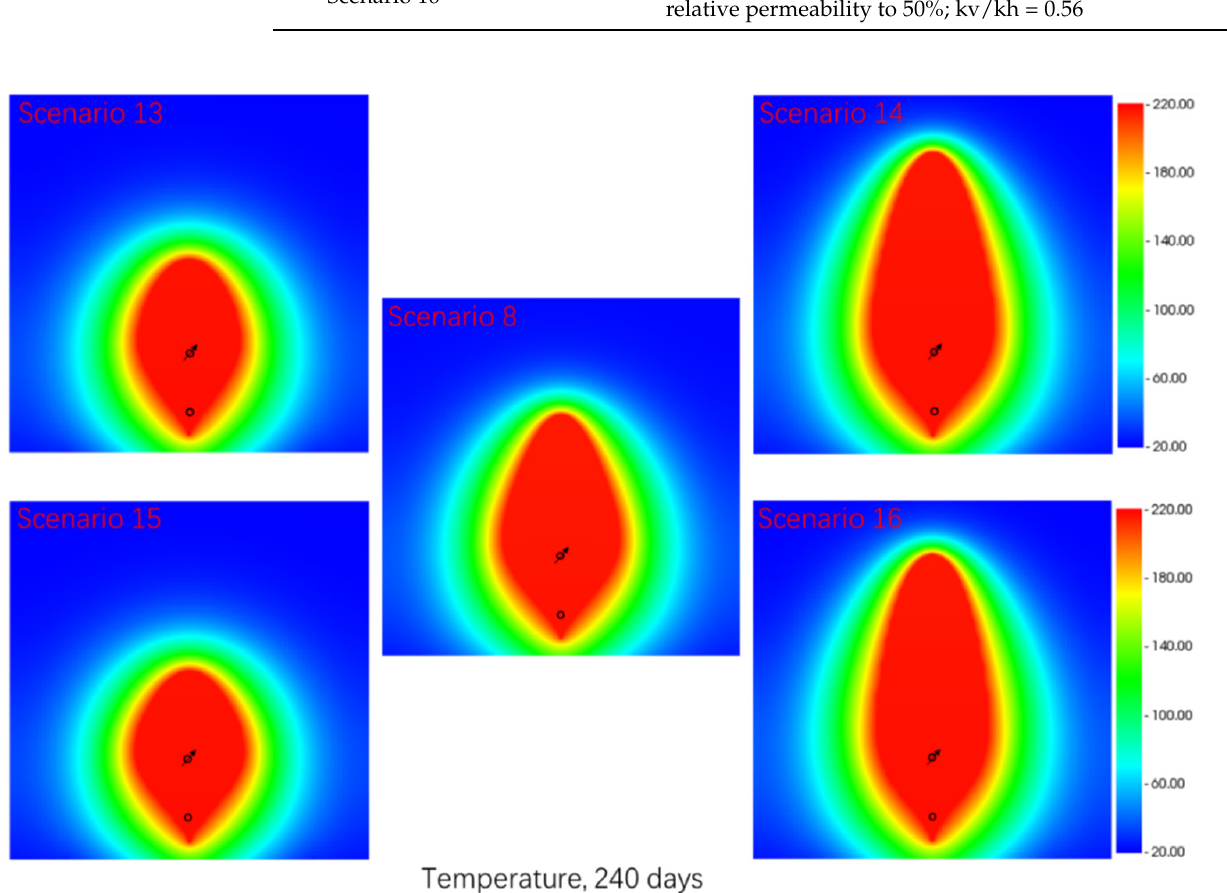
Figure 14. Cross-sectional temperature distributions of scenarios 8, 13, 14, 15 and 16 under varying countercurrent relative permeability values and vertical permeabilities using kv/kh ratios.